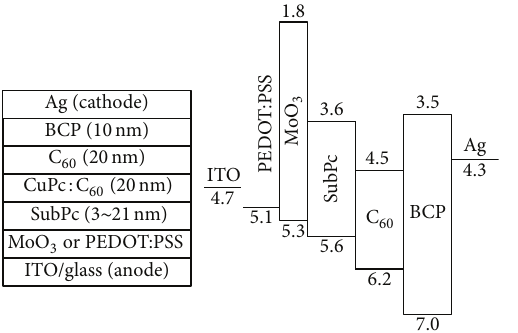
Table 1: Photovoltaic performance parameters of devices